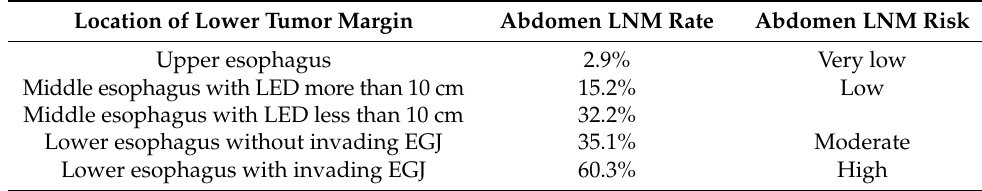
Table 7. Abdomen LNM risk